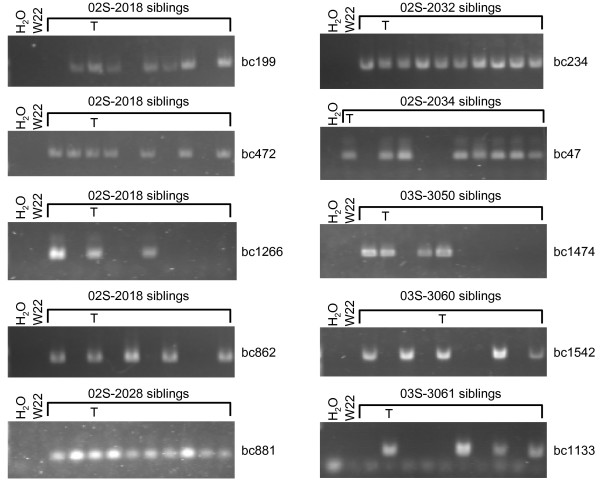
Examples of PCR validation assays for UniformMu FSTs. Each panel shows PCR products that were amplified using a MuTIR primer and a FST locus-specific primer. Each primer was tested on the initial template DNA used to develop the UniformMu FSTs (lane T) as well as DNA extracted from siblings (denoted by brackets). No DNA template controls were included in all assays (lane H2O). W22 DNA was used to confirm that the insertion site did not amplify in the recurrent inbred parent of the UniformMu population.